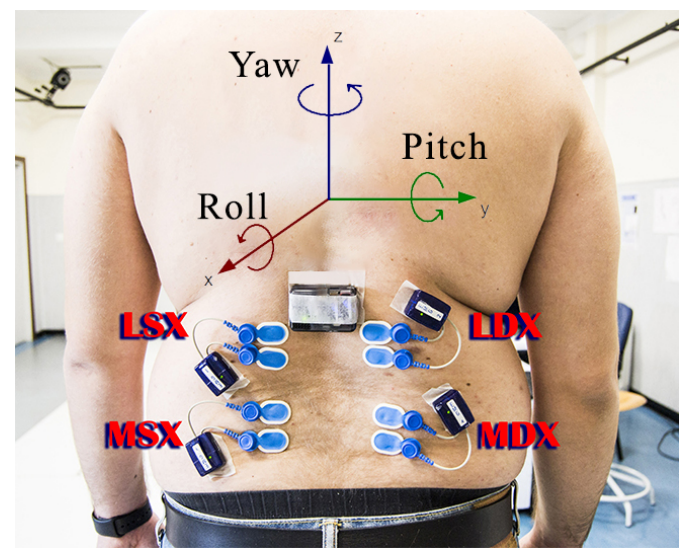
Figure 1. Positioning of the sEMG sensors and the wearable device on the subject under